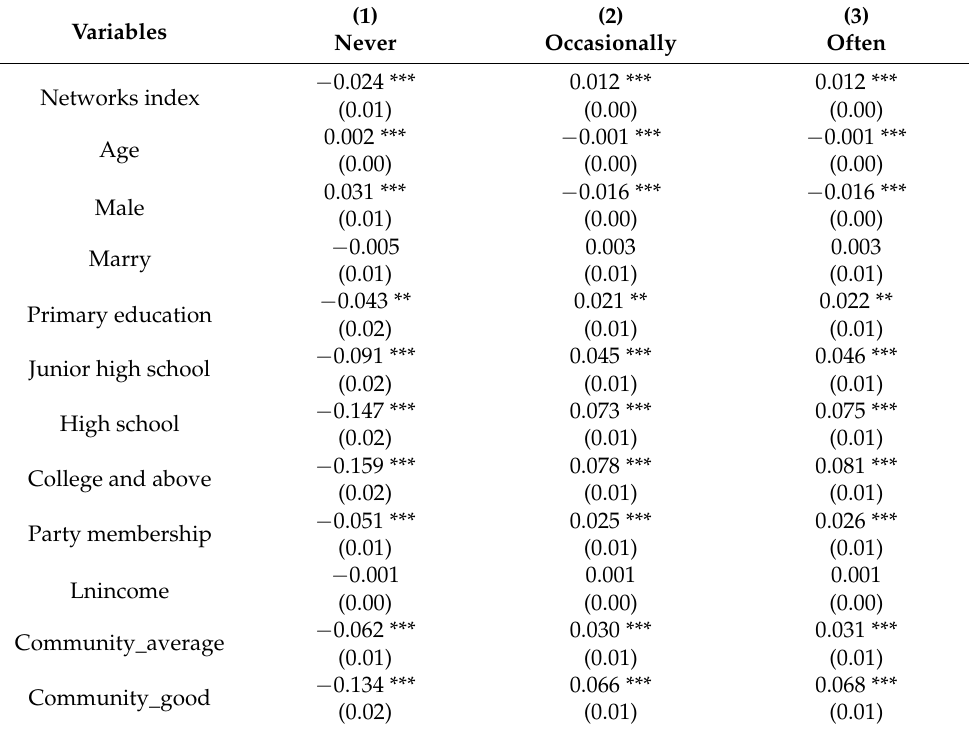
Table A7. Marginal Effects of Social Networks on Waste-Separation